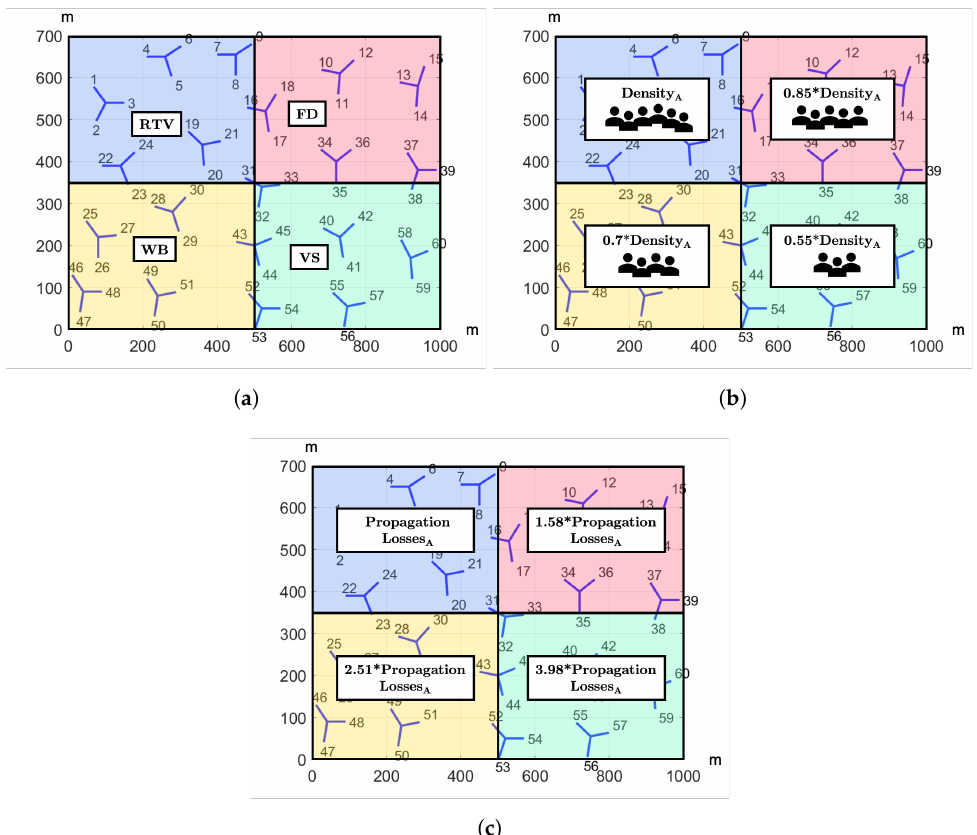
Figure 3. Configurations of the scenario in second, third and fourth tests. ( a ) Second scenario setup. ( b ) Third scenario setup. ( c ) Fourth scenario